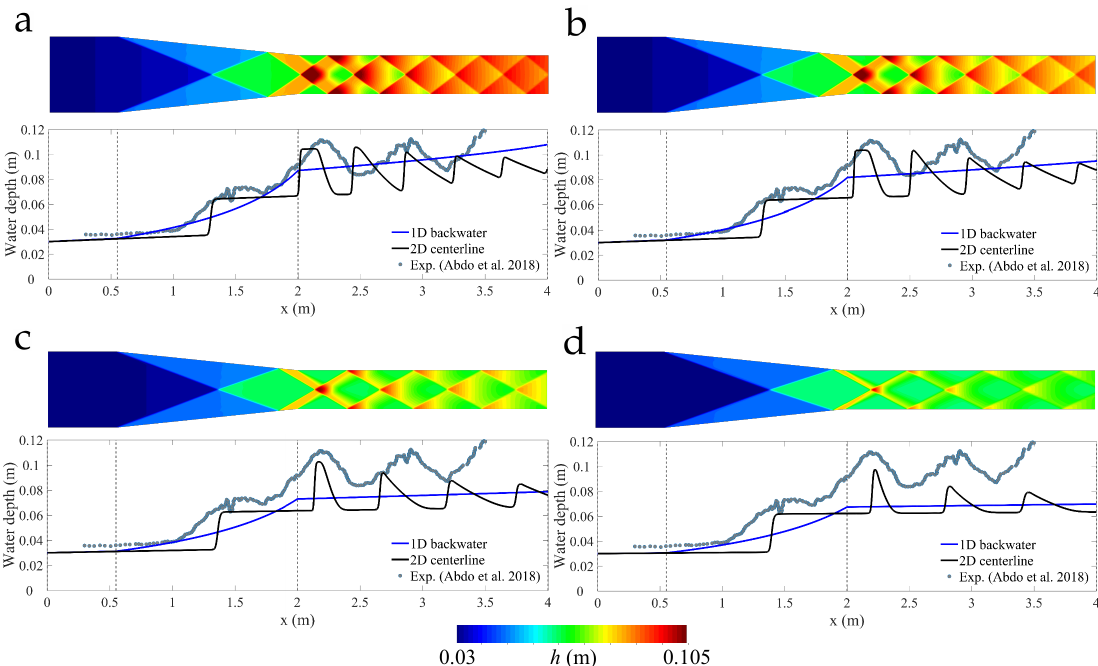
Figure 6. Model validation: supercritical flow in a channel contraction: impact of bottom friction. We repeat the analysis of Figure 5 using several values of the Manning coefficient, and show the maps of water depth (2D simulations) and 1D profiles for n = 0.011 (panel a ), n = 0.01 (panel b ), n = 0.0075 (panel c ) and n = 0.005 (panel d